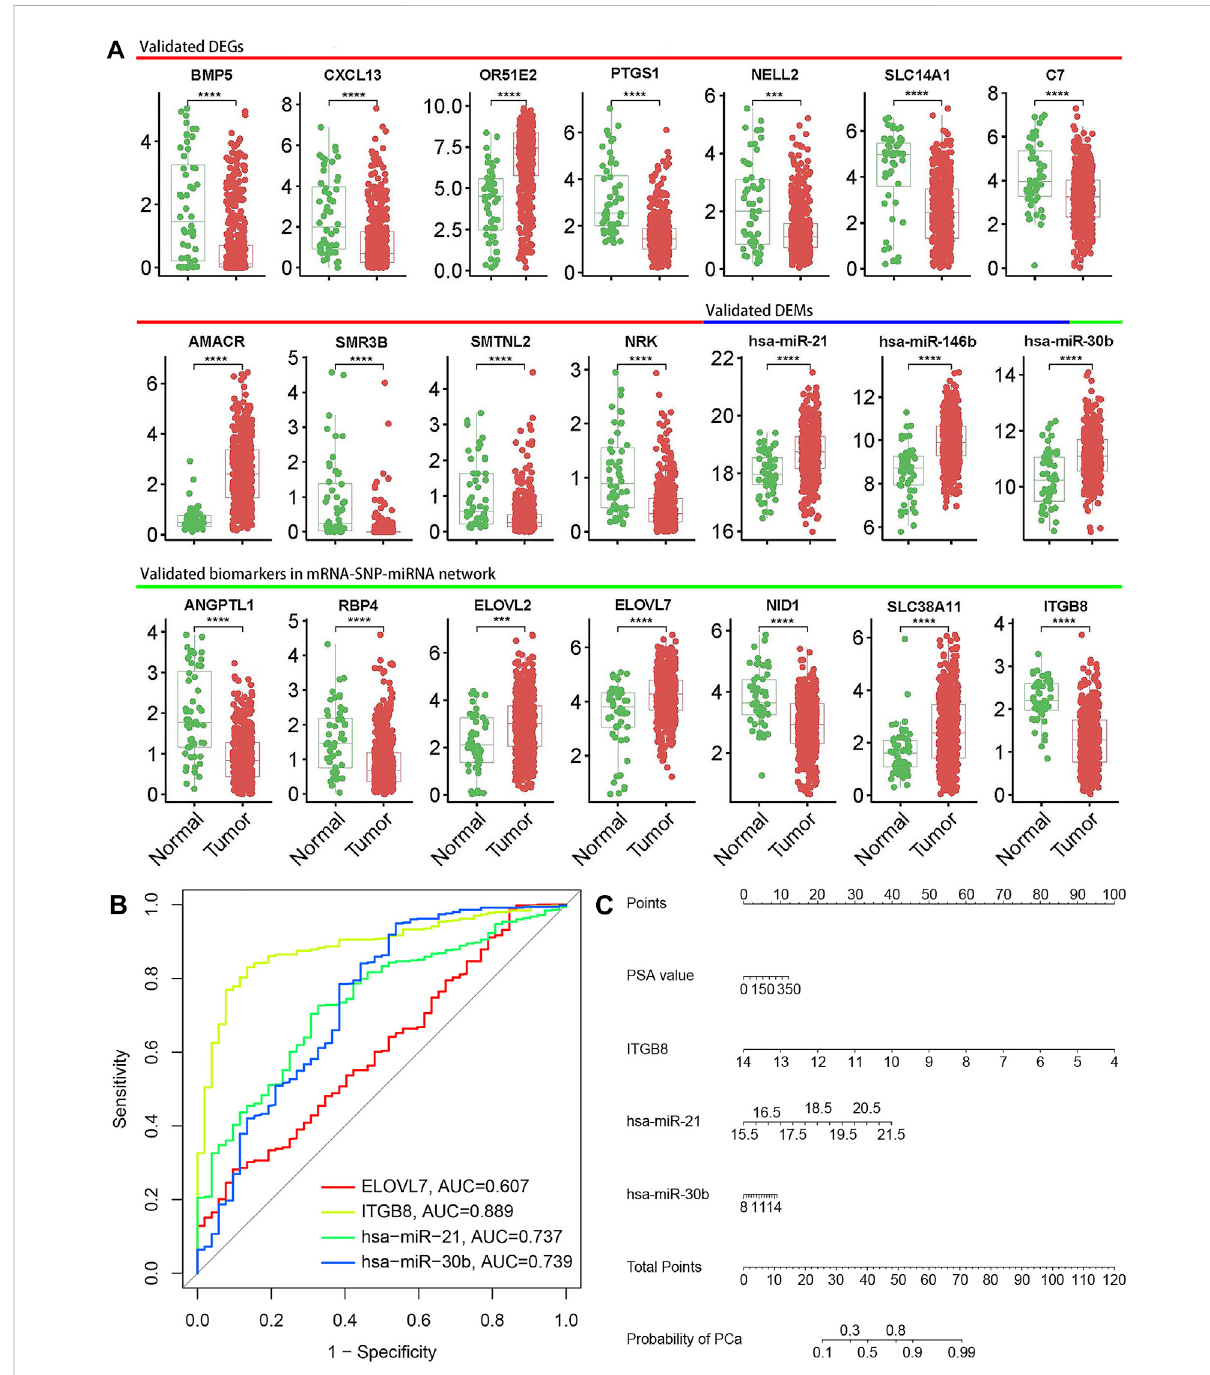
FIGURE 5 Validationanddiagnosticperformanceofbiomarkers. (A) Boxplotsofrepresentativebiomarkers.Signi fi cant p -valueswereshowninboxplots;* means p value ≤ 0.05, ** means p value ≤ 0.01, *** means p value ≤ 0.001 and **** means p ≤ 0.0001, if not indicated, means p value > 0.05. (B) Receiver operation characteristic (ROC) analysis to analyze the ability of ELOVL7 , ITGB8 , hsa-miR-21, and hsa-miR-30b to distinguish PCa from normalcontrols. (C) NomogramforpredictingtheriskofPCa.Thepointsofeachvariablecouldbeobtainedfromthepointscaleaxis,thentotal pointscouldbecalculatedbysummingupeachsinglepoint.TheprobabilityofPCacouldbeestimatedbylocatingthesumonthetotalpointsaxisof the